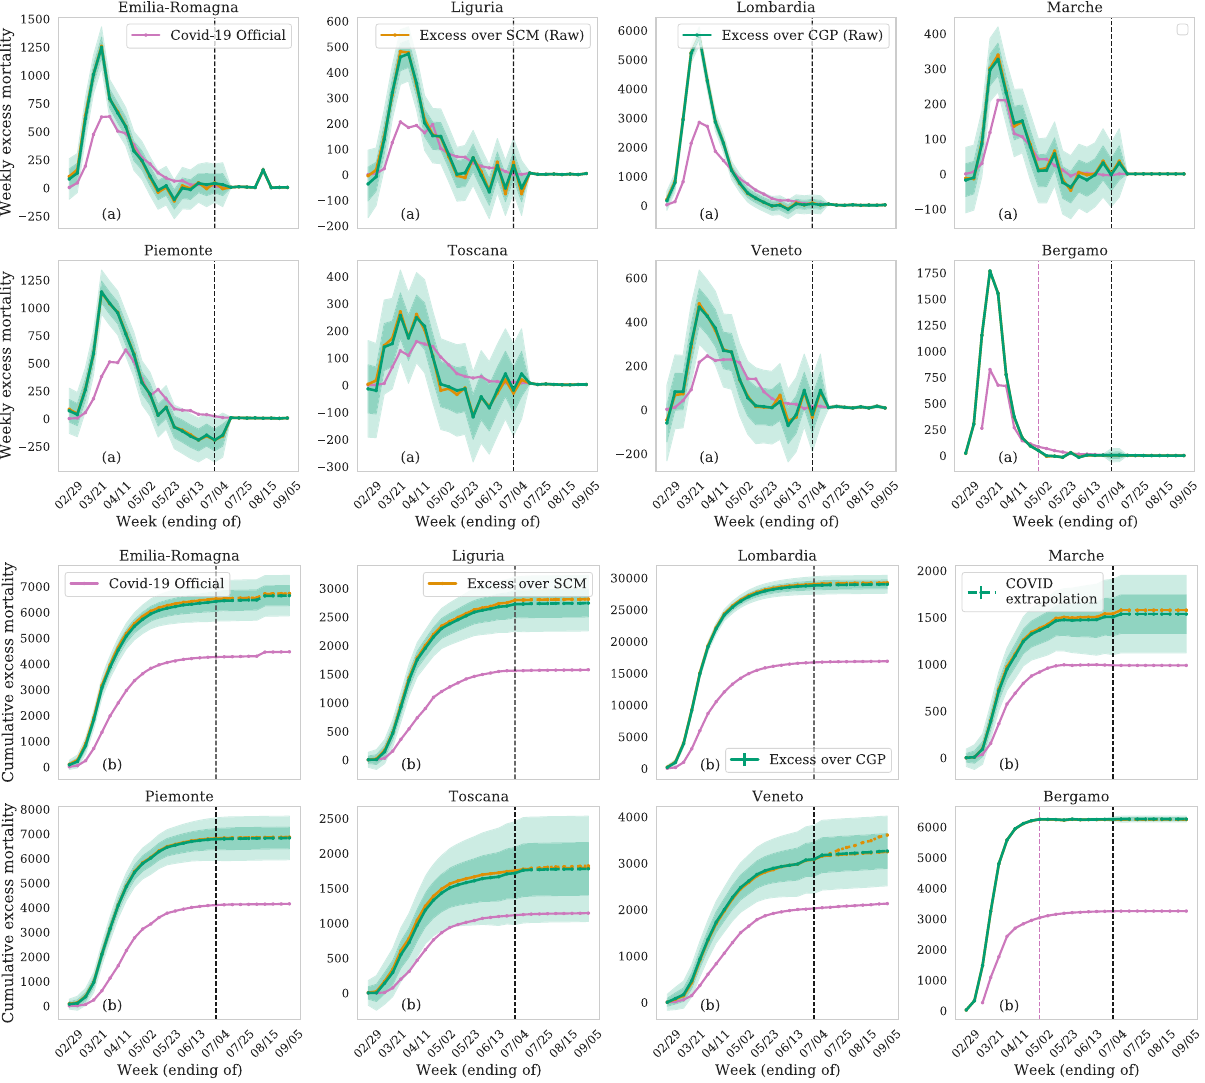
Fig. 2 Excess mortality compared with reported COVID-19 deaths in regions of Northern Italy and the province of Bergamo. ( a ) Excess weekly deaths, and ( b ) cumulative excess deaths, over the predicted counterfactual in comparison to the reported COVID-19 deaths (in pink) for the period since February 23rd (available COVID-19 data). Estimates from both the synthetic controls method (SCM, orange) and conditional Gaussian Process (CGP, green) counterfactuals agree. We show 1 and 2 − σ error (68% and 95% con fi dence interval) from the variance of the Gaussian model. We fi nd that COVID-19 deaths are under-reported by multiple factors for every period and every region. We extrapolate the data excess beyond June 27th, which is the last week with available total mortality data (dashed-black line), with dashed-lines. To do this, we make the conservative assumption after June 27 that the reported COVID-19 deaths are accurate and account for the excess mortality over predicted